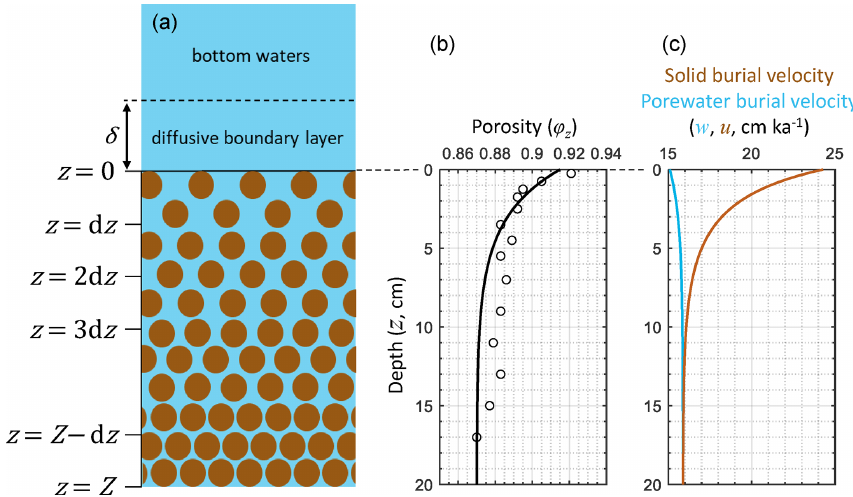
Figure 1. Schematic of RADI’s vertical structure alongside steady-state depth profiles of porosity ϕ z (see Eqs. 3 and 4), porewater ( u , solid light blue line) and solid ( w , solid brown line) burial velocities at in situ conditions taken at station 7 of Sayles et al. (2001). Burial velocity varies with depth due to porosity, as described in Sect. 2.3. The open circles in the porosity profile are porosity measurements from Sayles et al.